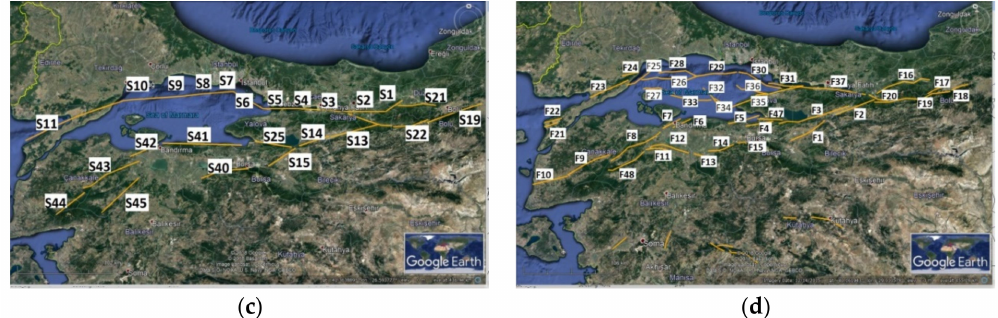
Figure 2. Source models developed for Marmara region: ( a ) [8] model 1, ( b ) [8] model 3, ( c ) [9], and ( d ) [10].